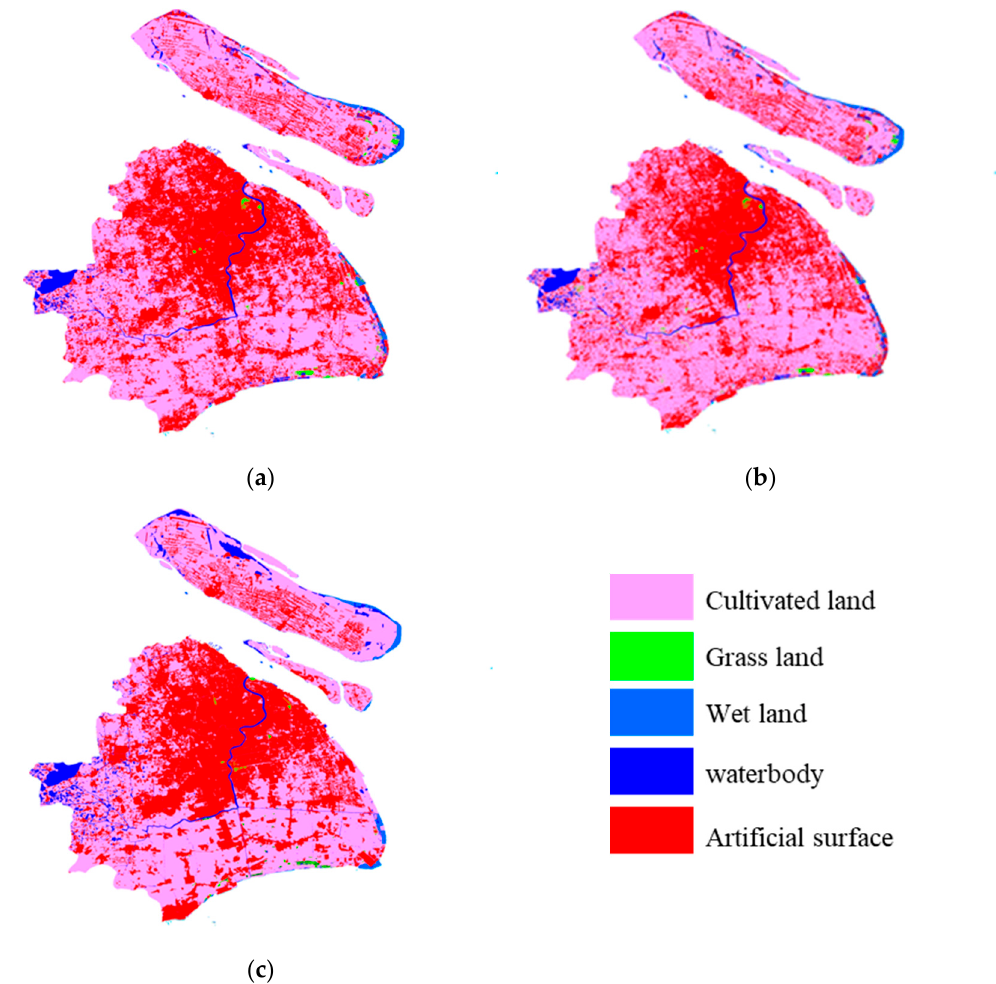
Figure 8. Land cover classification maps obtained using different methods: ( a ) ECVA_OB+SVM; ( b ) MCVA_PB + SVM; ( c ) GlobeLand30 2010.